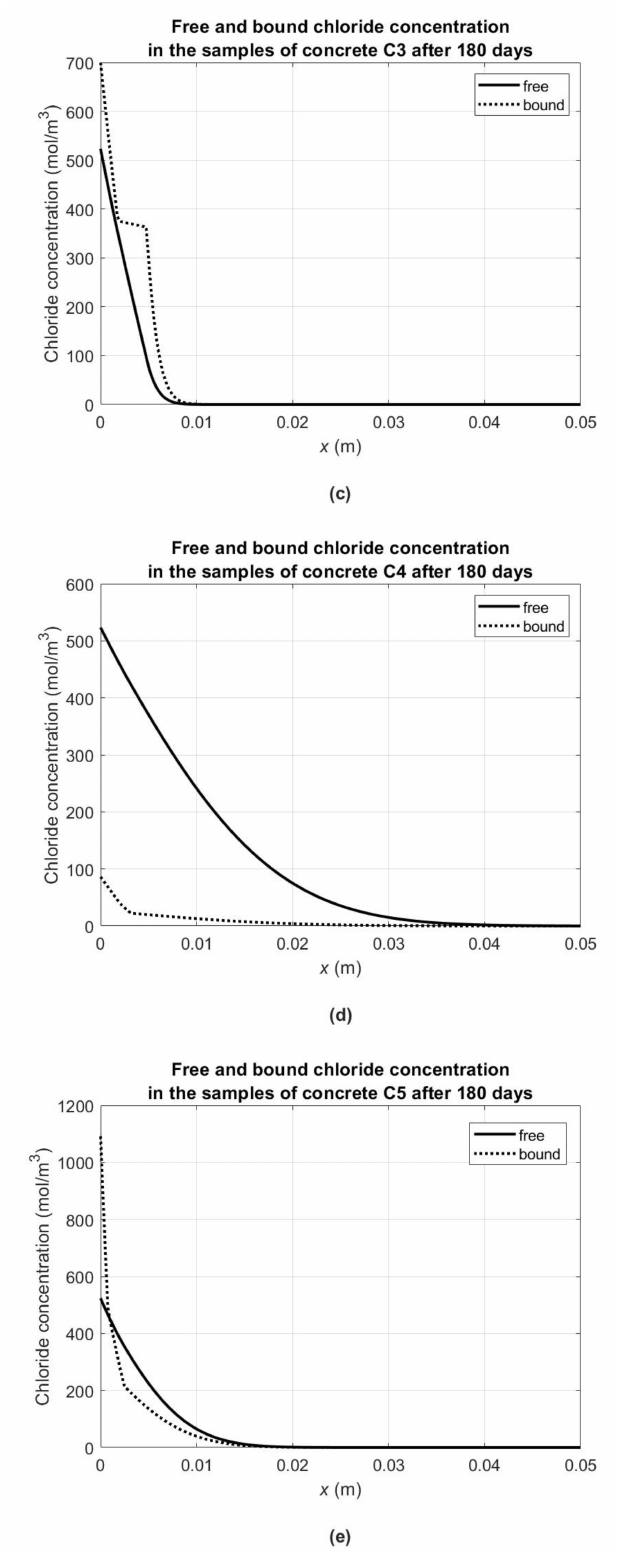
Figure 7. Variability of concentrations of free ( C f ) and bound ( C b ) chlorides in a function of the depth in the samples after 180 days of diffusion calculated with use of the material parameters presented in Table 5 for concrete C1 and Table 7 for concretes C2–C5. Concretes: ( a ) C1, ( b ) C2, ( c ) C3, ( d ) C4, and ( e ) C5. Coordinate x = 0 relates to the specimen external surface exposed to the chloride